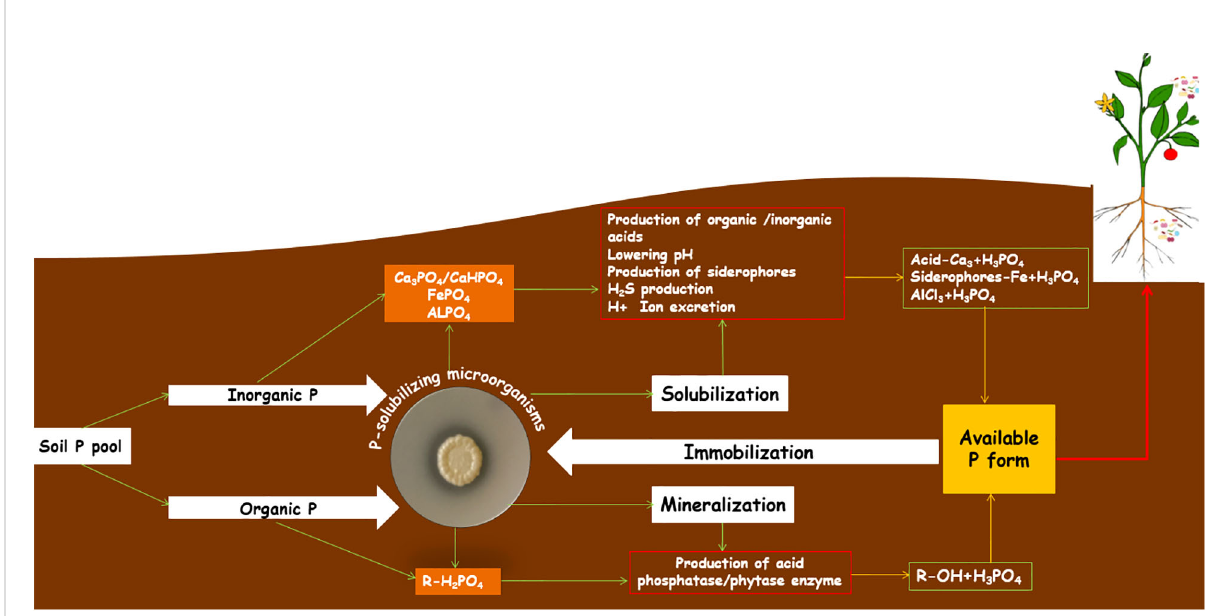
FIGURE 1 Schematic representation of solubilization/mineralization mechanisms of different P forms by P-solubilizing Streptomyces . Soil P is present in inorganic and organic forms. Phosphate-solubilizing Streptomyces induce P reactions by several mechanisms (production of organic and inorganic acids, siderophores, etc.) to release unavailable and immobilized inorganic P forms for plants (Ca-P, calcium phosphate; Fe-P, iron phosphate; Al-P, aluminum phosphate) by solubilization; while they secret extracellular enzymes (phosphatase and phytase) to release the organic P forms (orthophosphate, phosphonates, etc.) by mineralization process in order to provide the water-soluble form H 3 PO 4 to the